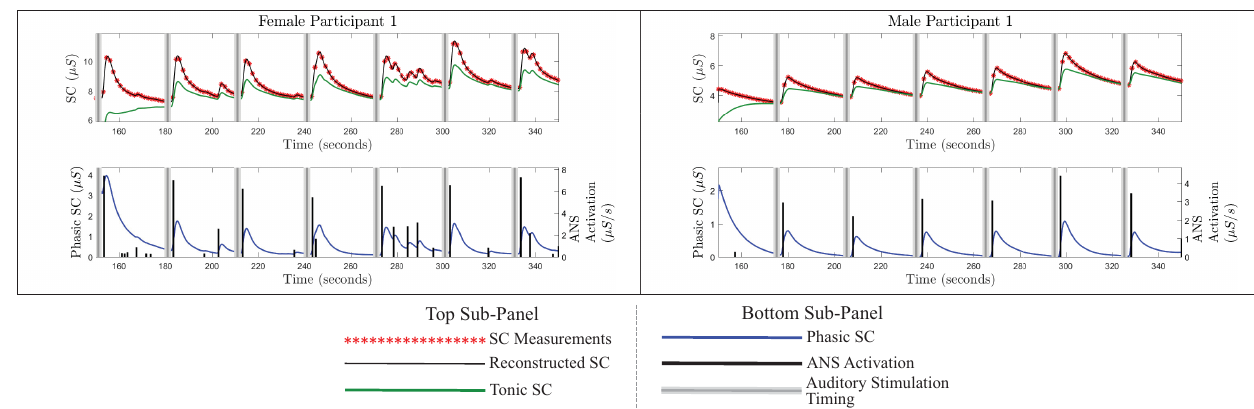
Fig 2. Estimated decomposition of the experimental SC signals for female participant 1 and male participant 1. In each of the panels, i) the top sub-panel shows the experimental SC signal (red stars), the reconstructed SC signal (black curve), the estimated tonic component (green curve), and the timings of the auditory stimulations (gray vertical lines); ii) the bottom sub-panel shows the estimated phasic component (blue curve), estimated ANS activation timings and amplitudes (black vertical lines) and the timings of the auditory stimuli (gray vertical lines).